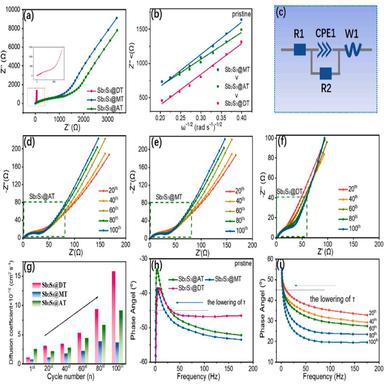
Pristine Nyquist plots (a) and the linear relations between Z'' and ω− 1/2 at the 5th, 10th, 20th, 30th, and 50th cycles(b) of as-prepared samples. The relative fitting circuit of as-obtained samples. (c) The Nyquist plots of Sb2S3@AT(d), Sb2S3@DT(e) and Sb2S3@MT(f) at the 20th, 40th, 60th, 80th and100th cycles. The relative diffusion coefficients of as-obtained samples. (g) The relationships between phase angle and frequency for as-fabricated samples at the pristine cycle. (h) The relationships between pha